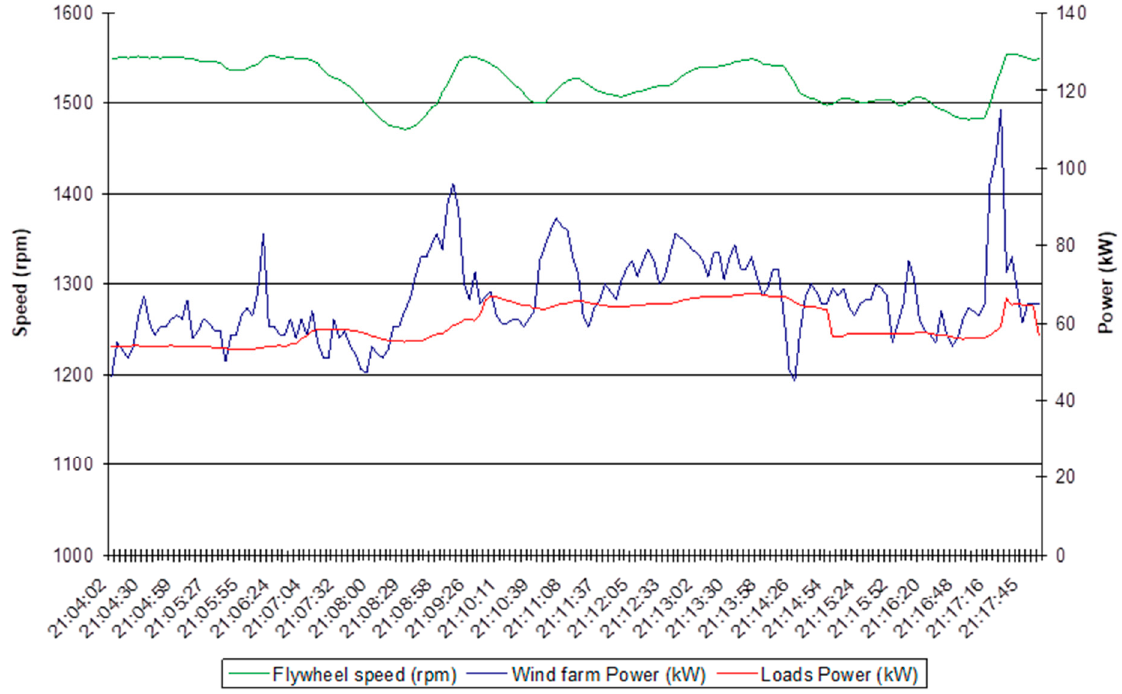
Figure 2. Selection of monitored data from an off-grid wind-powered SWRO system.